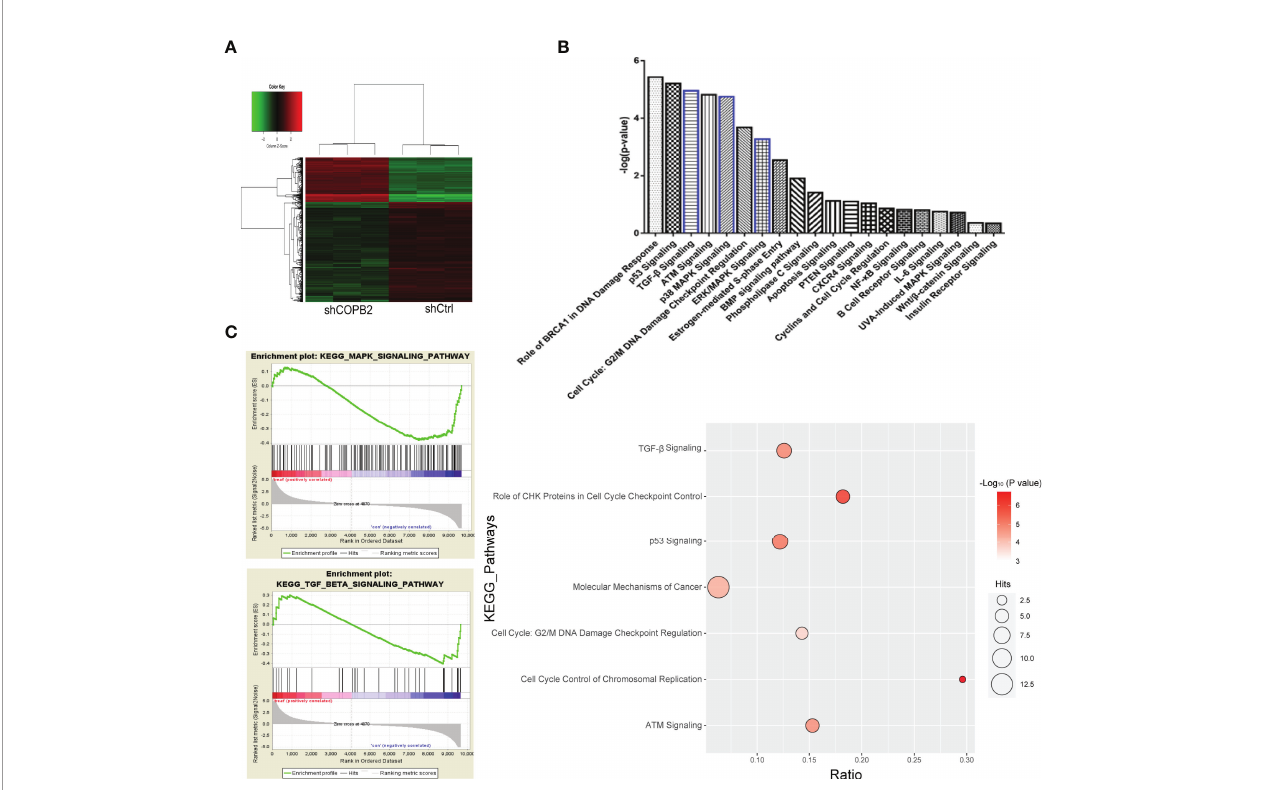
FIGURE 6 | GeneChip analysis for COPB2 knockdown and control groups, and IPA. (A) Hierarchical clustering graph of transcriptome expression of COPB2- knockdown samples and control samples in heatmap analysis. Pseudo-color was used to represent the intensity of gene expression from the array analysis. Green and red denote low and high expression, respectively. (B) IPA analyses the enrichment of downstream signaling pathways. (C) Correlation in enrichment plot, the horizontal axis represents genes, and the vertical line in the middle plot represents genes in this pathway. The ‘ h ’ (red) indicated that the pathway was enriched in the positively related pathway; the ‘ l ’ (blue) indicated that the pathway was enriched in the negatively related